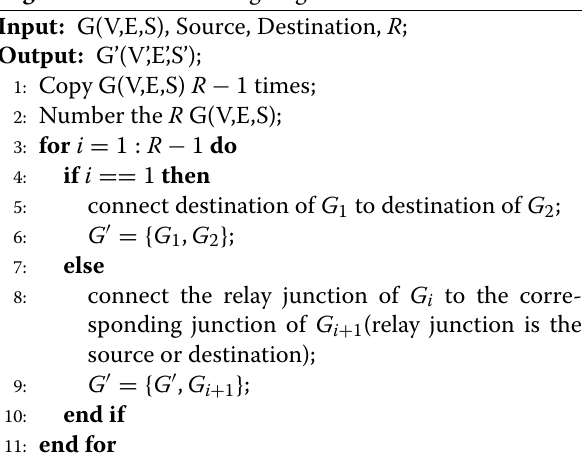
Algorithm 1 Mirror image algorithm